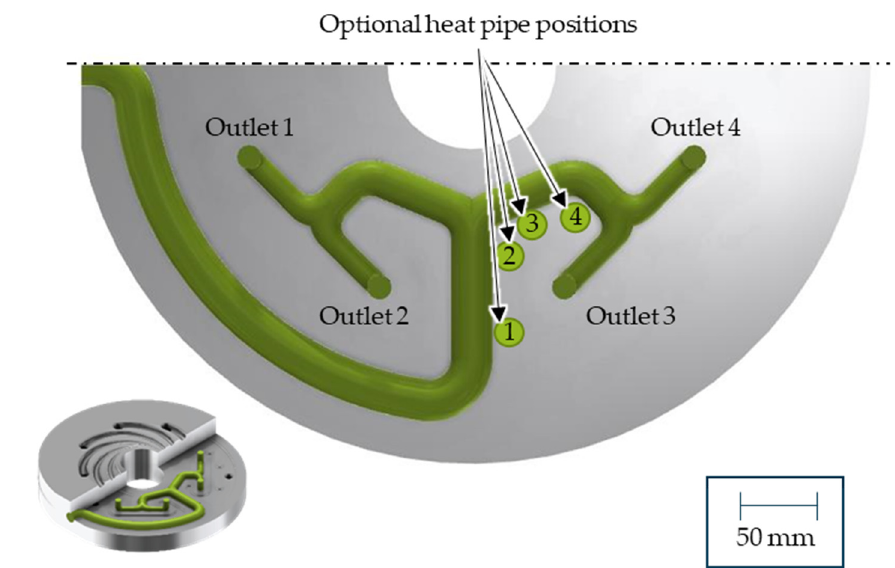
Figure 9. Heat pipe position 1–4.